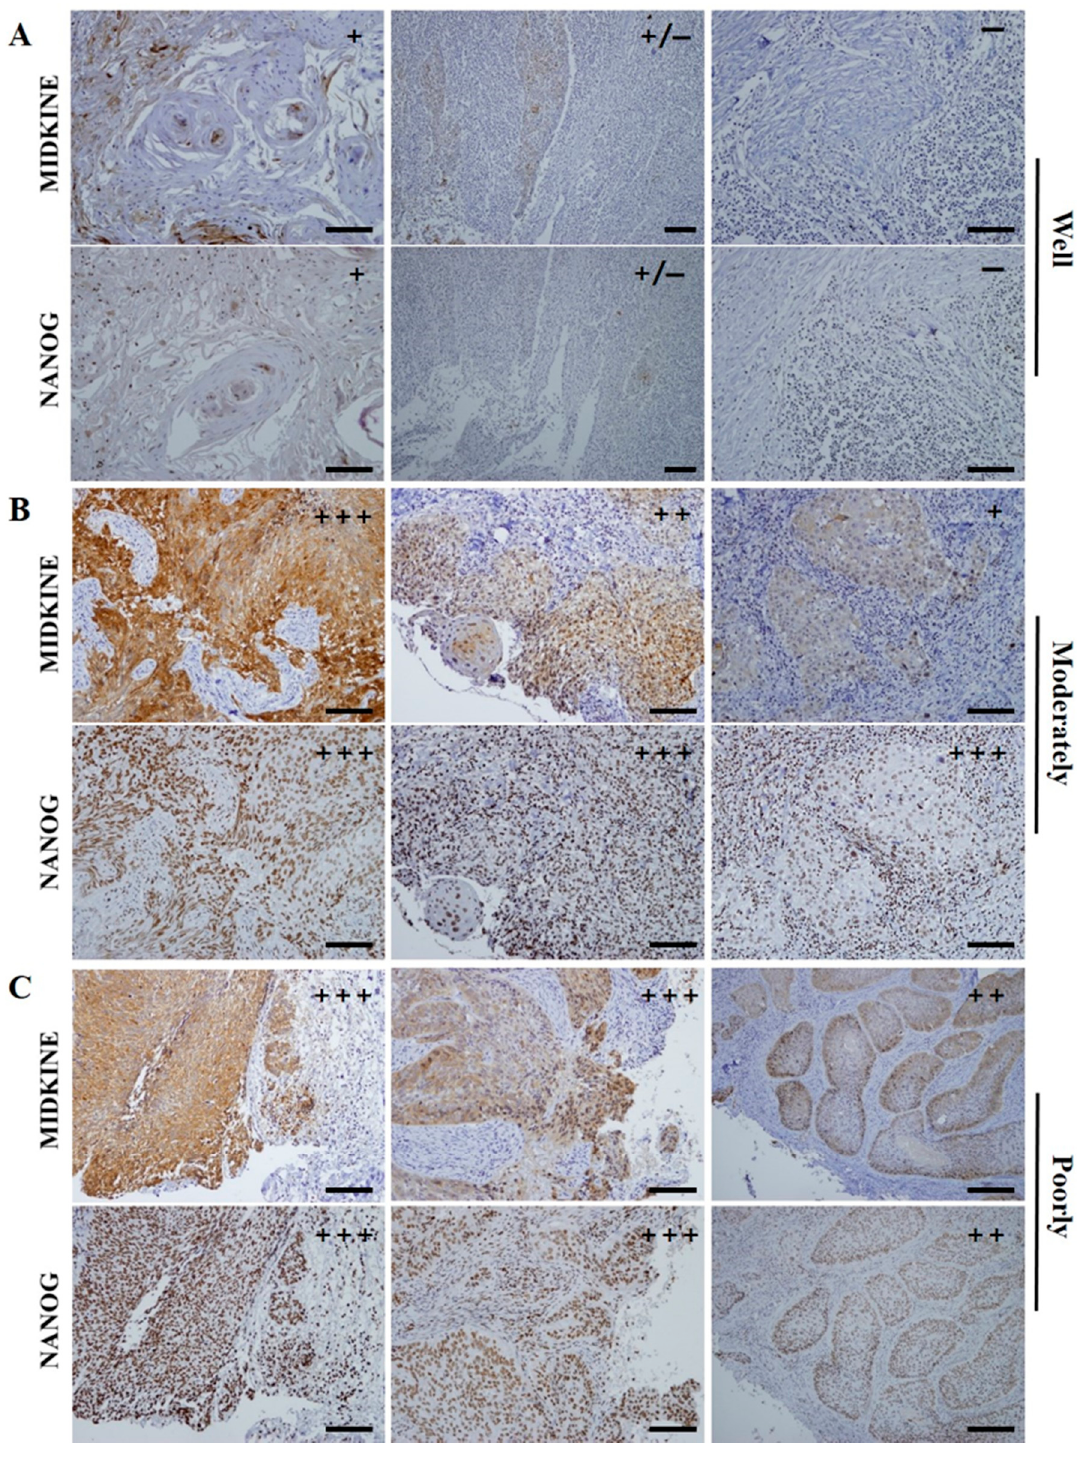
Figure 2. Representative serial section images of IHC staining of MK and NANOG in the pretreatment OSCC biopsy specimens as their histopathological grades. ( A ) In well differentiated OSCCs, weak or negative expression of MK and NANOG is usually detected; ( B , C ) high-grade tumors, moderately- or poorly-differentiated OSCCs, dominantly revealed the enhanced (strong and moderate) expressions of MK and NANOG proteins. The expression patterns these two marker proteins, including immunostaining intensity and positive cell ratio, revealed highly similar features in OSCC specimens. In particular, enhanced co-localization of MK and NANOG proteins was usually detected in the cancer cells of high-grade tumors. Scale bar = 100 µm.